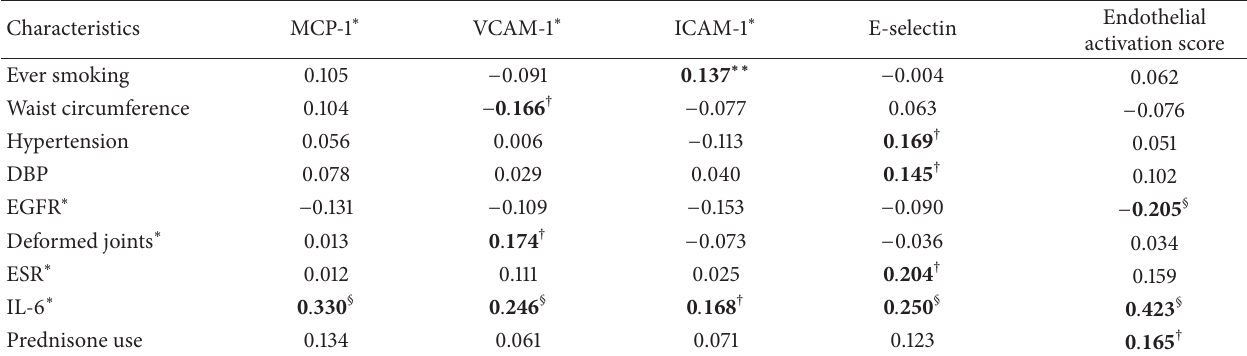
Table 2: Independent relationships of modifiable conventional cardiovascular risk factors and disease characteristics with endothelial activation in 217 patients with RA.